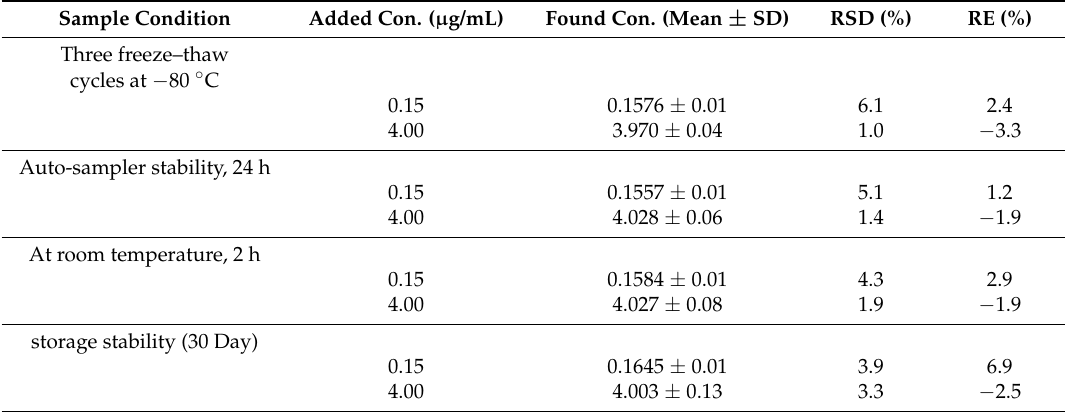
Table 4. Stability of CMME in dog plasma under various storage conditions ( n = 3).